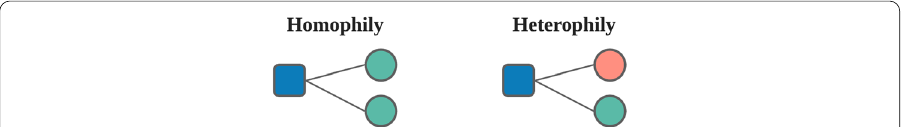
Fig. 3 Homophily and heterophily effect in bipartite networks. Squares represent the node set of actors in survey rosters; circles represent the node set of survey participants; node colors represent different node